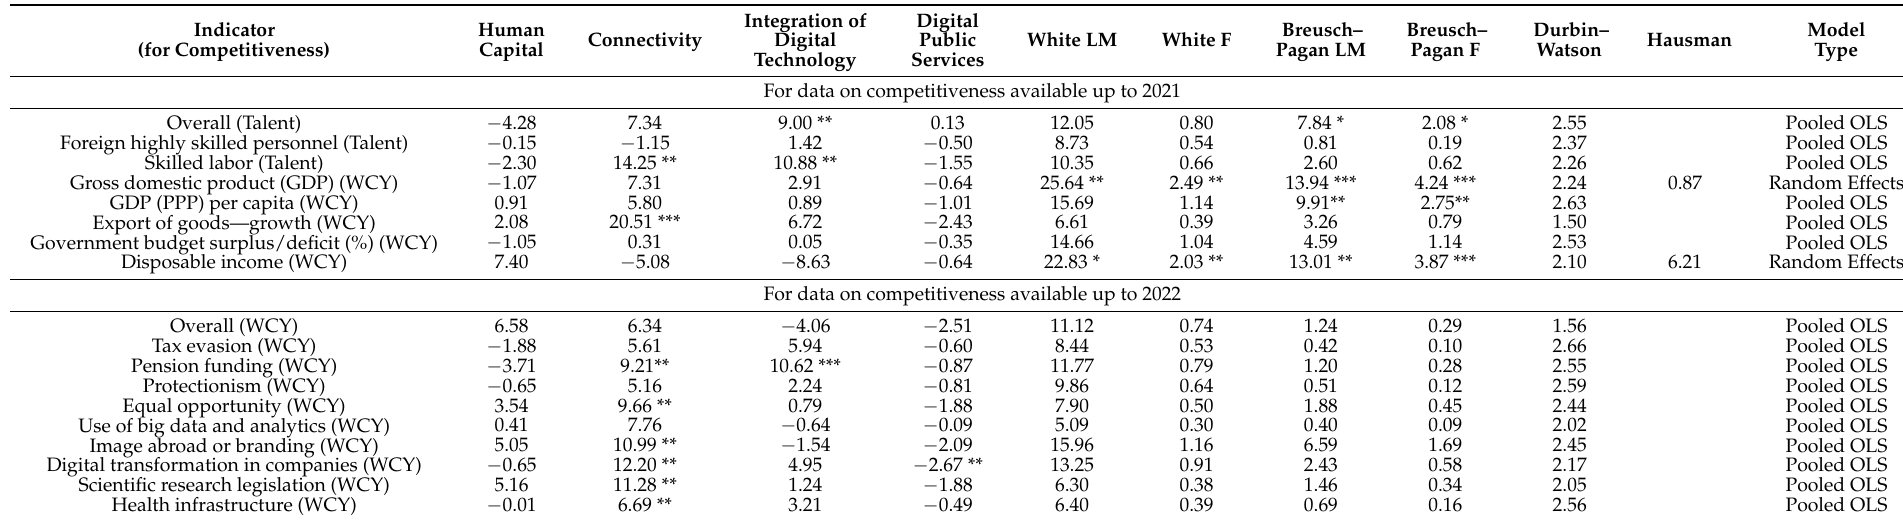
Table 5. Results for the scenario when DESI components are considered for Central and Eastern European